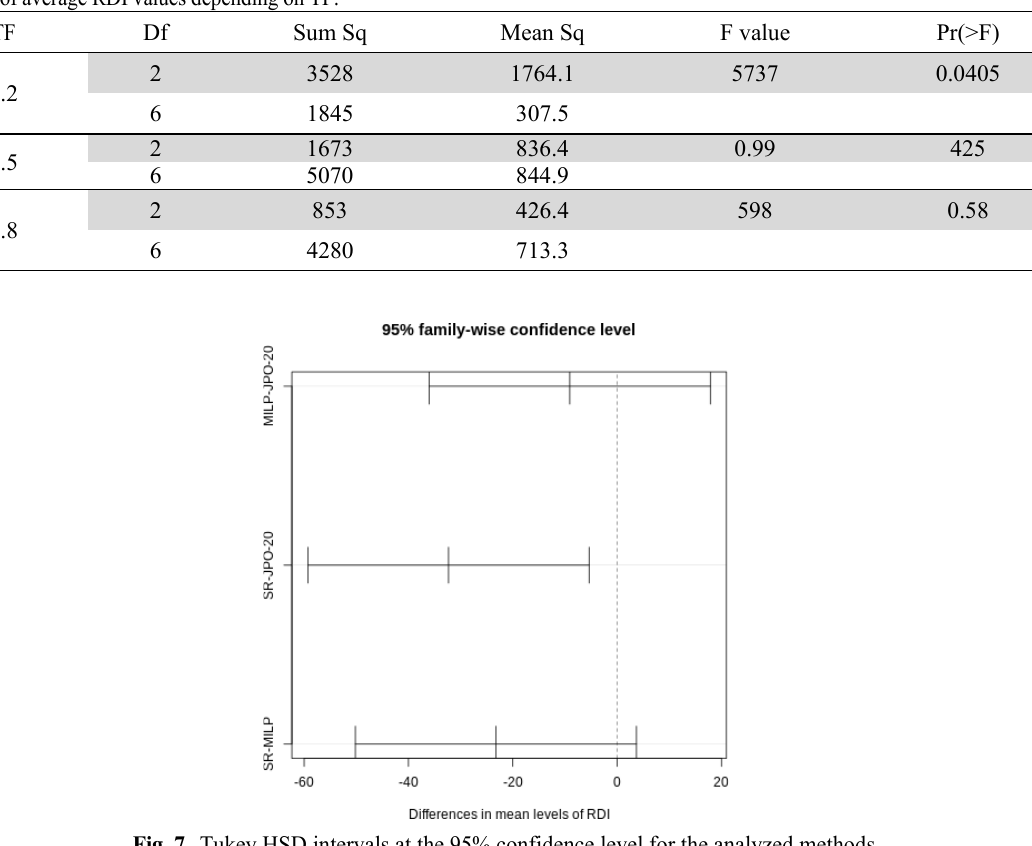
Fig. 7. Tukey HSD intervals at the 95% confidence level for the analyzed